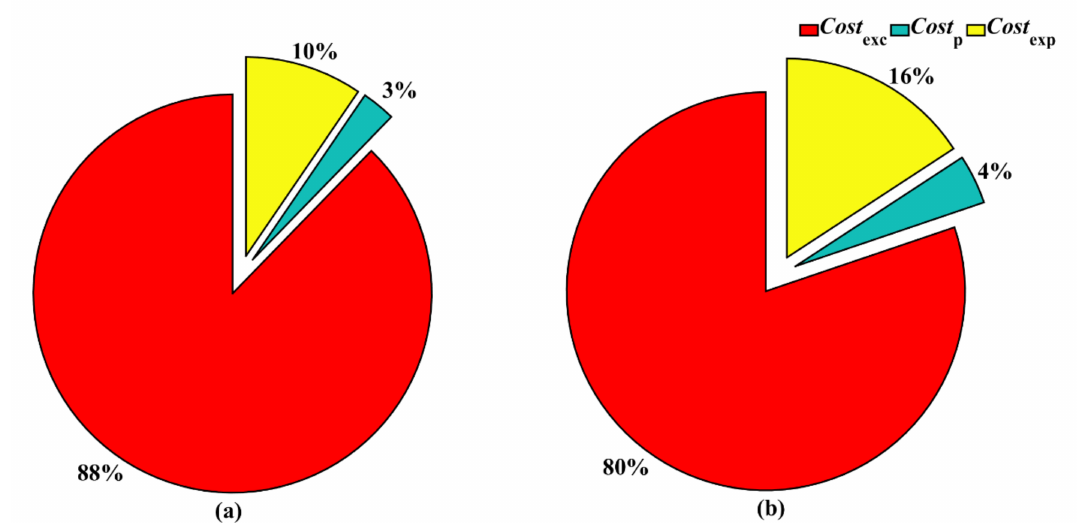
Figure 16. The proportion of cost of key components. ( a ) proportion of the average value of the total investment cost of the key components. ( b ) proportion of the investment cost of key components of the DORC